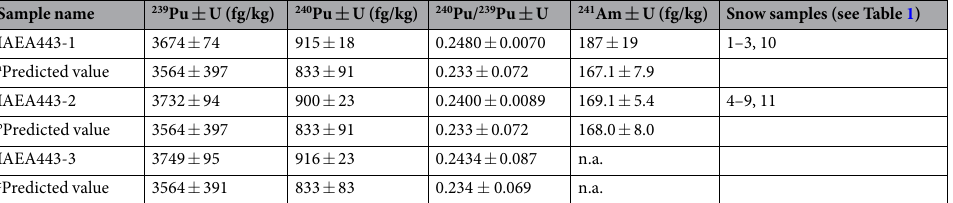
Table 3. Analytical results of Pu isotopes and 241 Am in IAEA-443 (Irish Sea water). IAEA443-1,2,3: this study; a Predicted value: as of July 30. 2015; b Predicted value: as of June 10. 2016; c Predicted value, as of Nov. 24. 2016; U, expanded uncertainty (k = 2); n.a., not analysed; snow sample number (see Table 1) analysed together with indicated reference material.